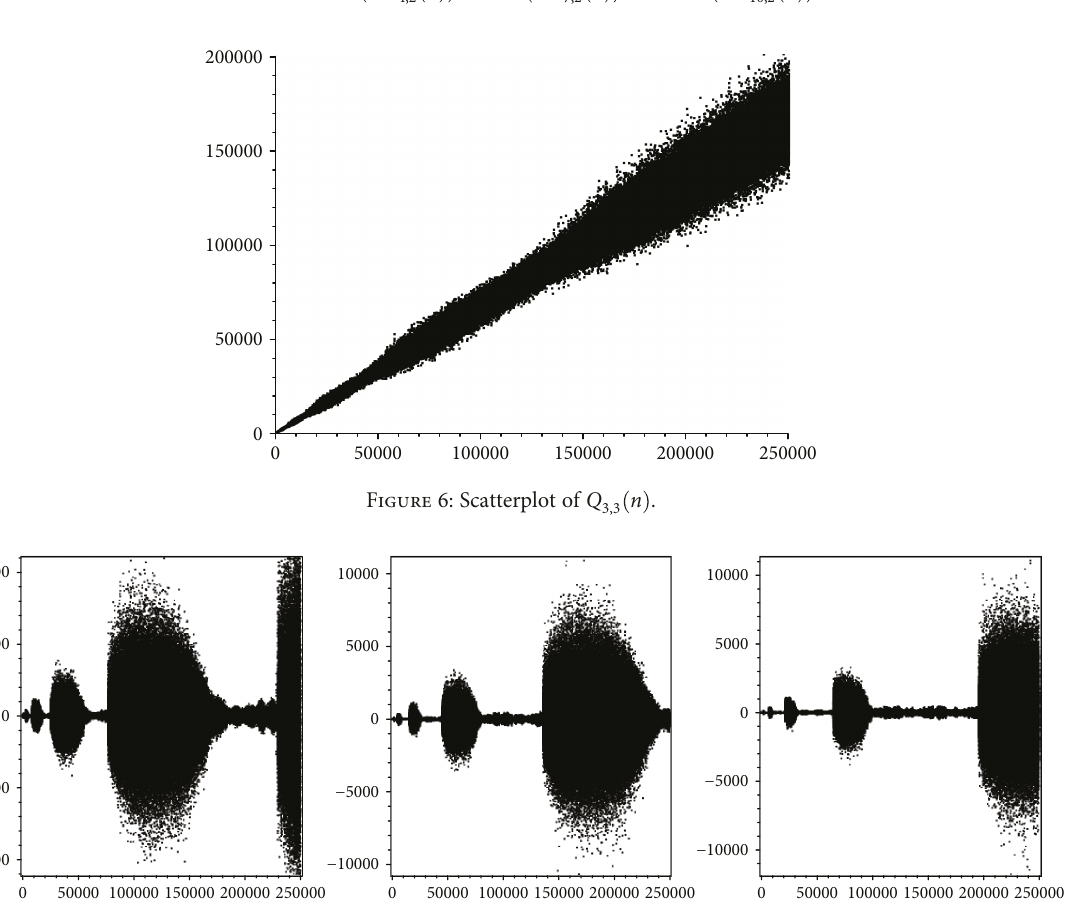
Figure 5: Blue: α k , S